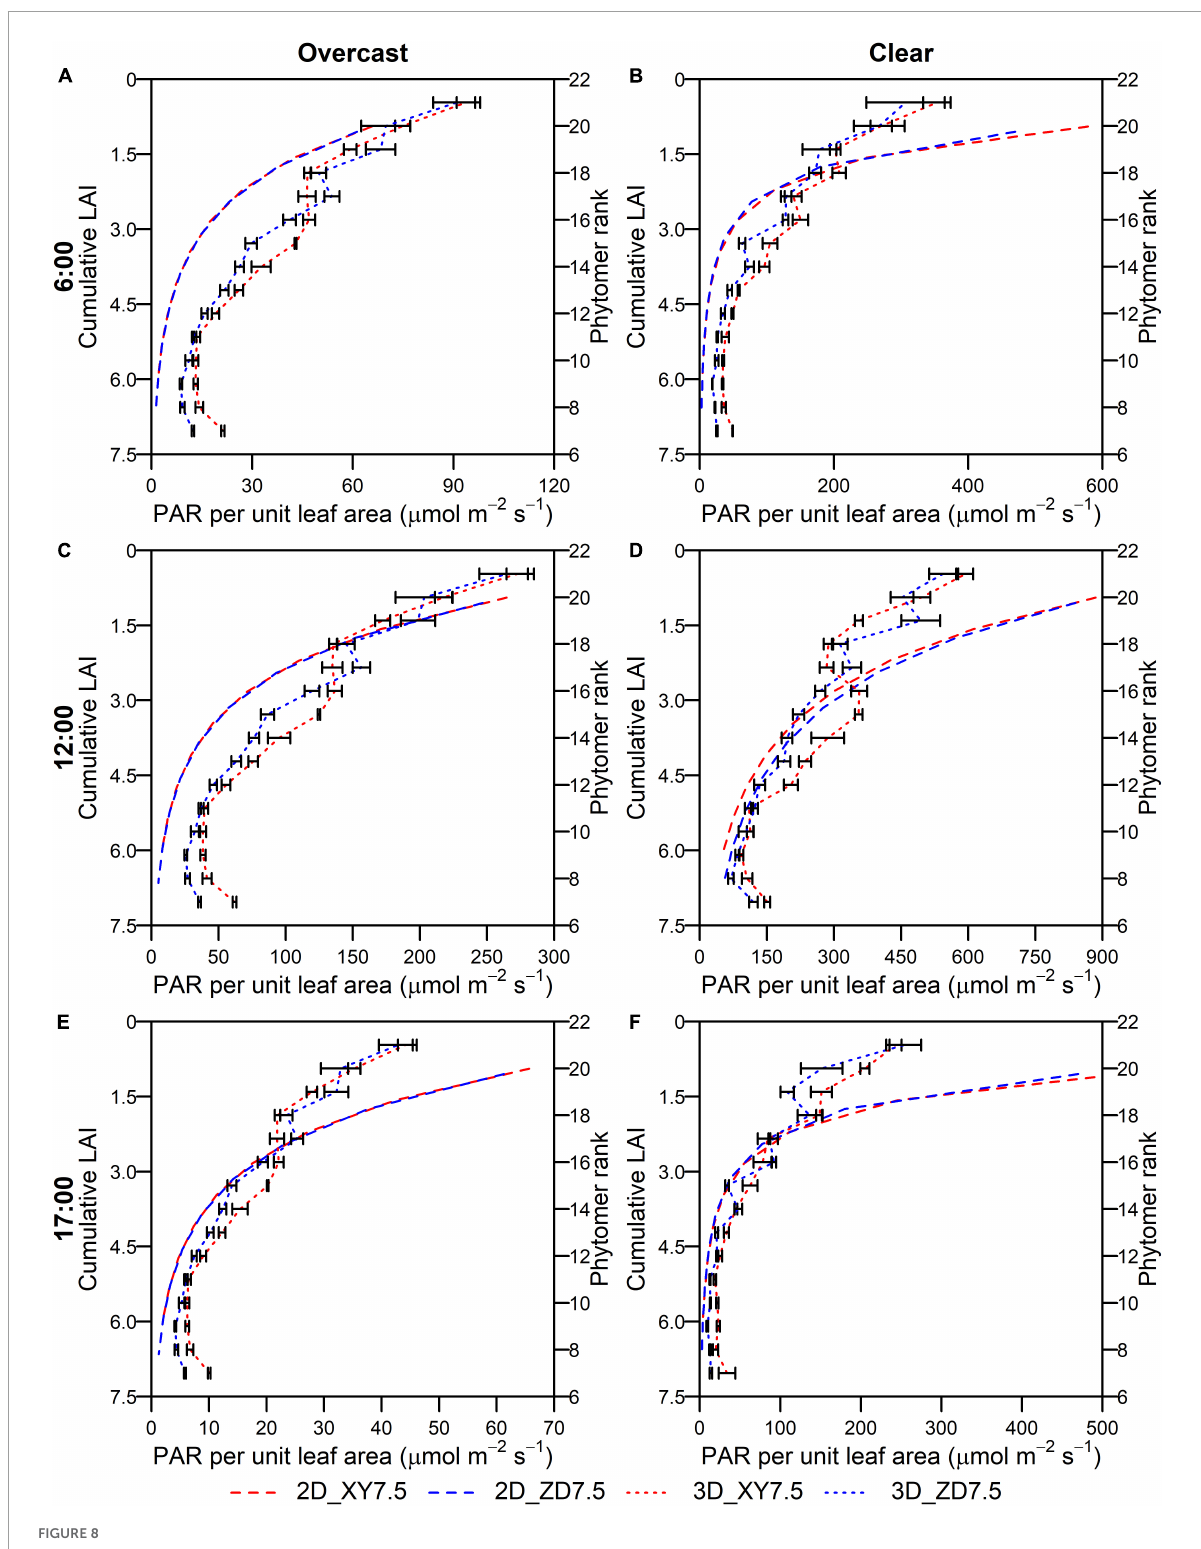
FIGURE8 Intercepted PAR per unit leaf area at different cumulative LAI by the 2D model (dashed in left y -axis) and ranks by the 3D model (dotted in the right y -axis) over canopy at 6:00 (A,B) , 12:00 (C,D) , and 17:00 (E,F) for ZD958 (blue) and XY335 (red) at the density of 7.5 plant m - 2 on an overcast day (A,C,E) and a clear day (B,D,F) . Error bars indicate the